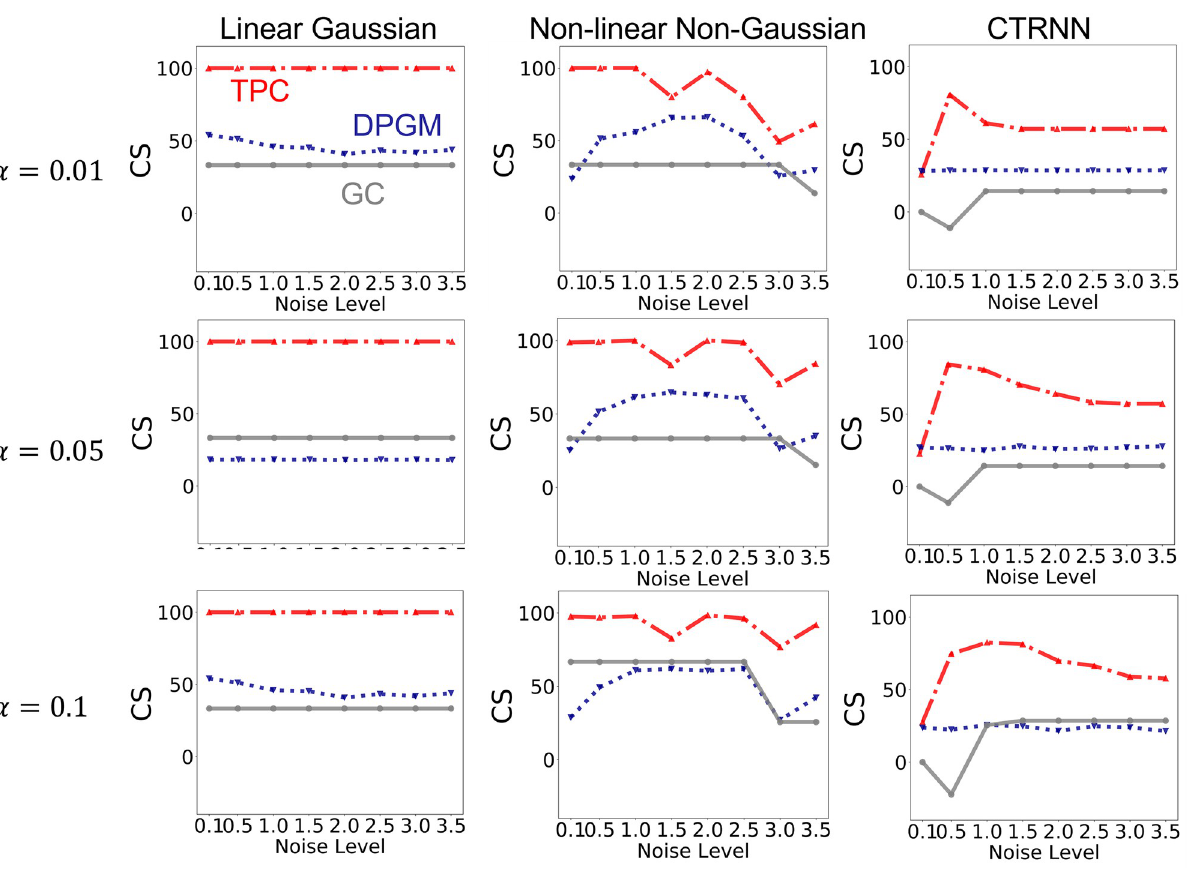
Fig 4. Comparative study over levels of noise and thresholding parameter. Combined Score of the three methods of CFC inference—TPC (red), DPGM (blue), GC (gray), over varying noise levels in simulation η = 0.1, 0.5, 1.0, ... , 3.5, for simulated motifs from Linear Gaussian, Non-linear Non- Gaussian and CTRNN paradigms (left to right), with thresholding parameter α = 0.01, 0.05, 0.1 (top to